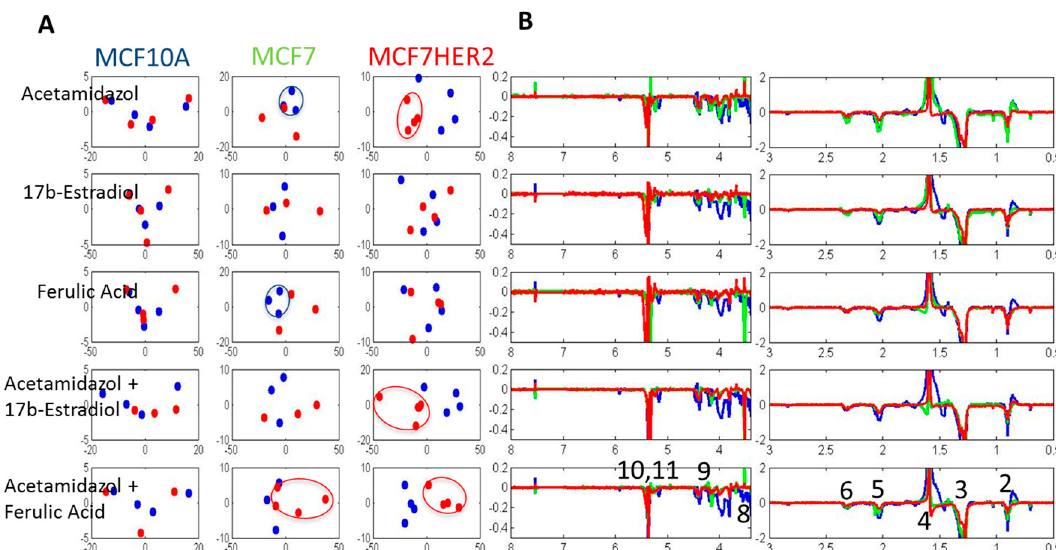
Figure 8. PCA of spectra of lipophilic metabolite for control (blue dots) and treated samples (red dots) in three cell lines. Labels correspond to peaks from: 1–CH3; 2–CH3 (L, Ch), CH2 (Ch); 3–CH2 (L, Ch); 4–CH2CH2COO (L) and H2O; 5–CH2CH=CH (L); 6–N(CH3); 7–Ar-H; 8–N(CH3)3; 9–CH2OCOR, CH2OPO2; 10–CHOCOR (lipids); 11–HC=CH (lipids, cholesterol). Assignment of peaks is based on Reference [31].